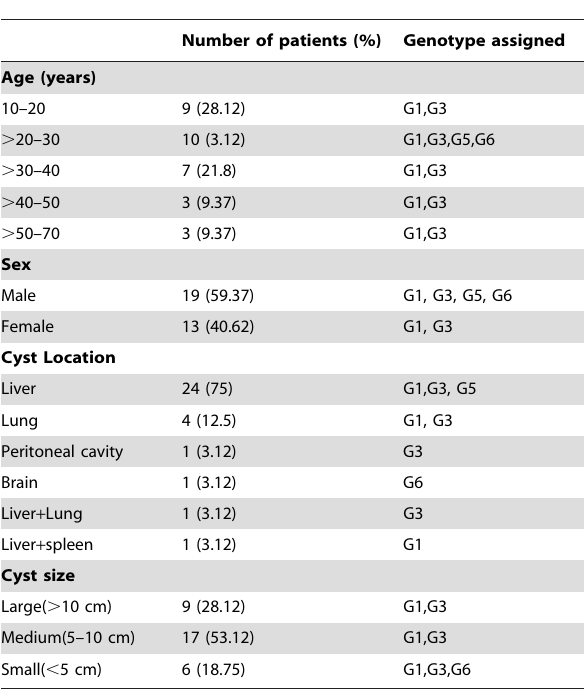
Table 1. Clinical characteristics of 32 cystic echinococcosis